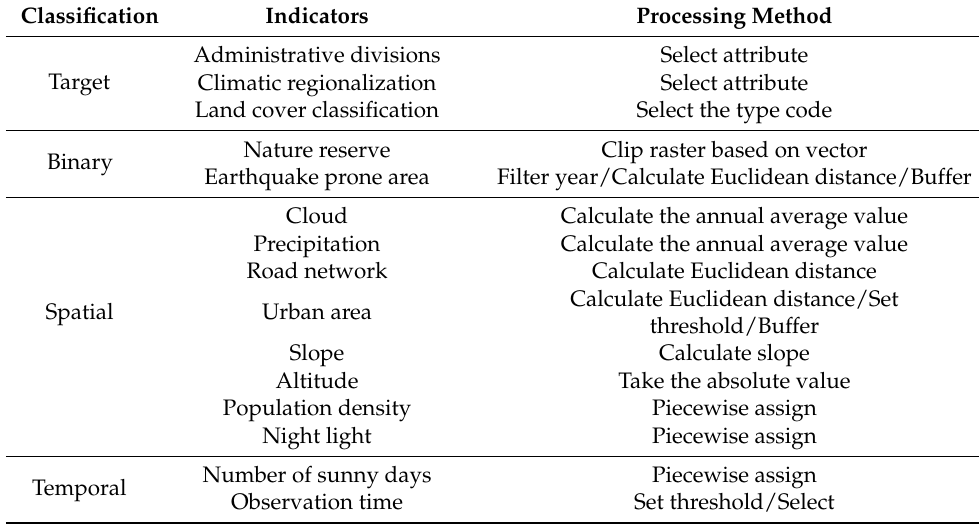
Table 2. Evaluation indicator data preprocessing